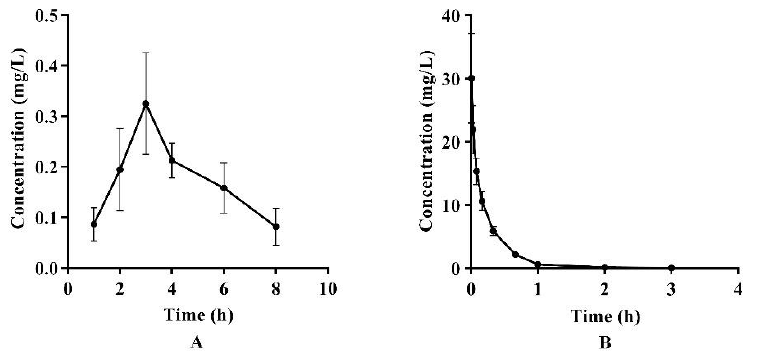
Figure 1. Mean plasma concentration – time curves of azalomycin F after ( A ) intragastric administra- tion of 26.4 mg/kg and ( B ) intravenous administration of 2.2 mg/kg to rats.